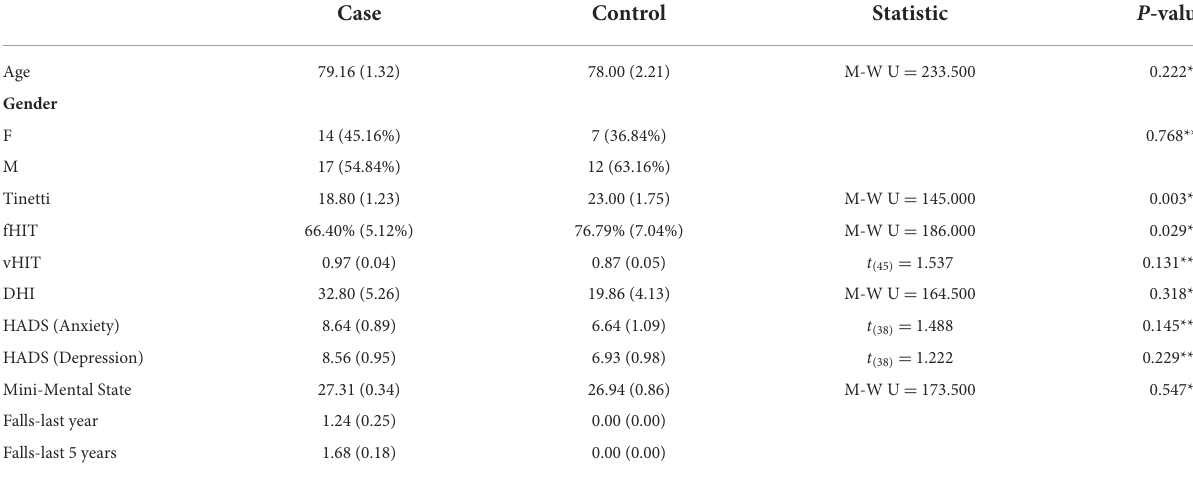
TABLE 1 Age, Tinetti Balance Test, fHIT, DHI, HADS, Mini-Mental Test scores, and falls during last year/last 5 years; data are expressed in mean and (standard deviation) for continuous measure or frequency and relative frequencies for categorical measures.